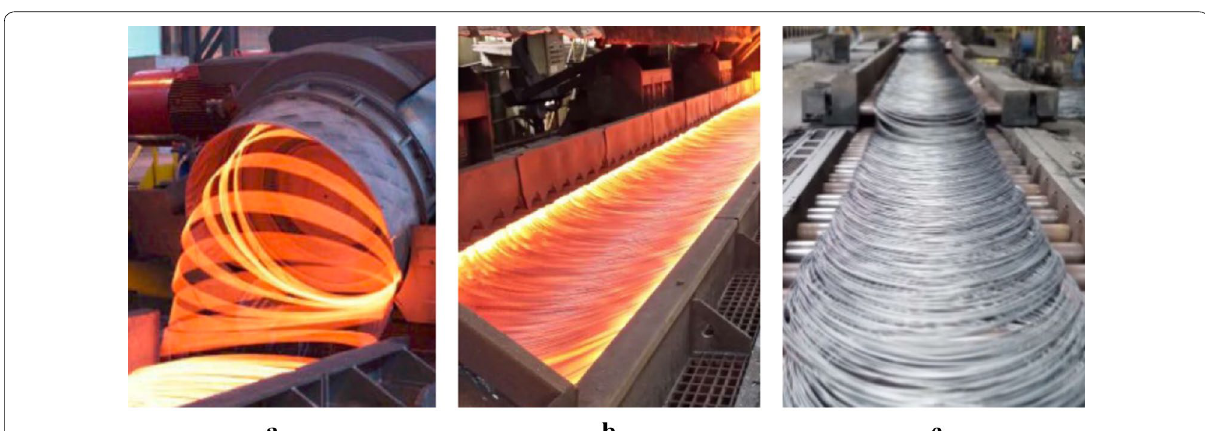
Figure 2 Laying out coils wire rod on the air cool convey: a coils wire out of the laying head machine; b hot coils wire on the air cool convey; c cold coils wire on the air cool convey (permission by Henan Jiyuan Iron & Steel Co.,